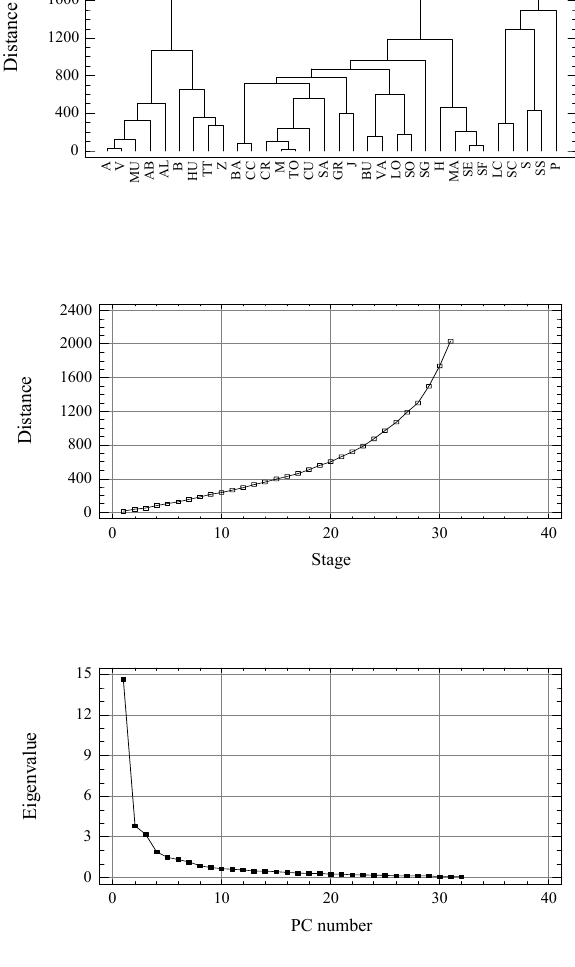
Fig. 2. Dendrogram (top), agglomeration distance plot (middle) and scree plot (bottom) for winter.